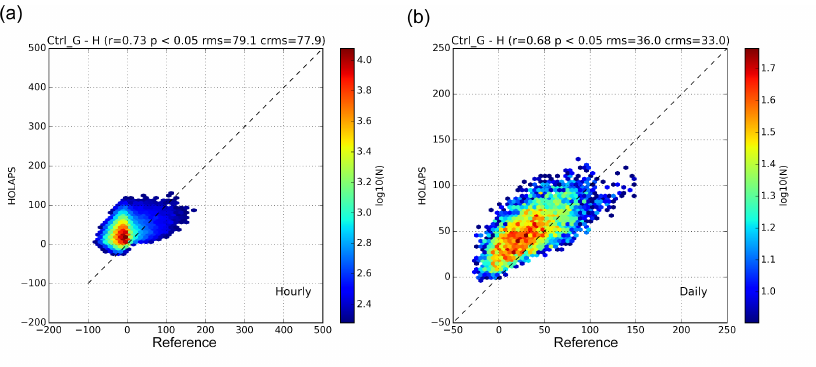
Figure 9. Comparison of HOLAPS sensible heat flux for (a) hourly and (b) daily timescale for the CTRL experiment using results from all stations and years. Units in Wm − 2 .